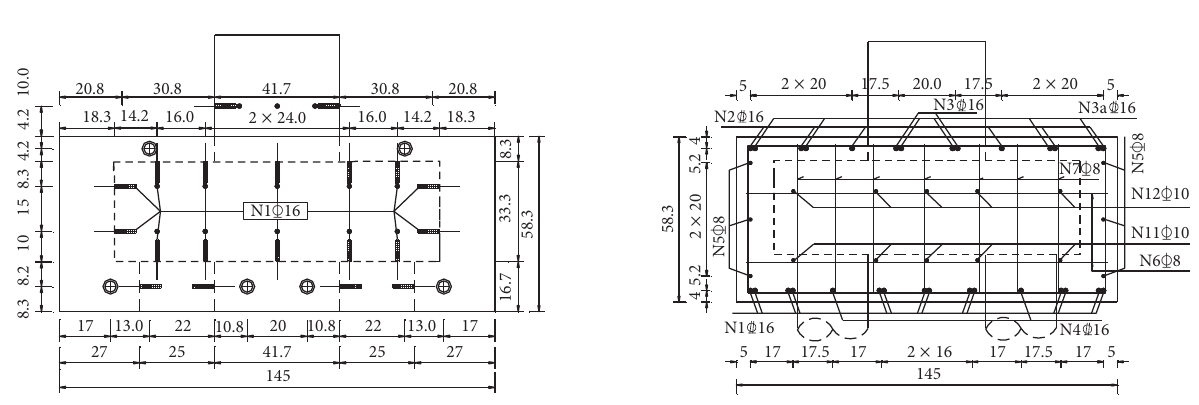
Figure 3: Plan view of underpinning beam (cm).